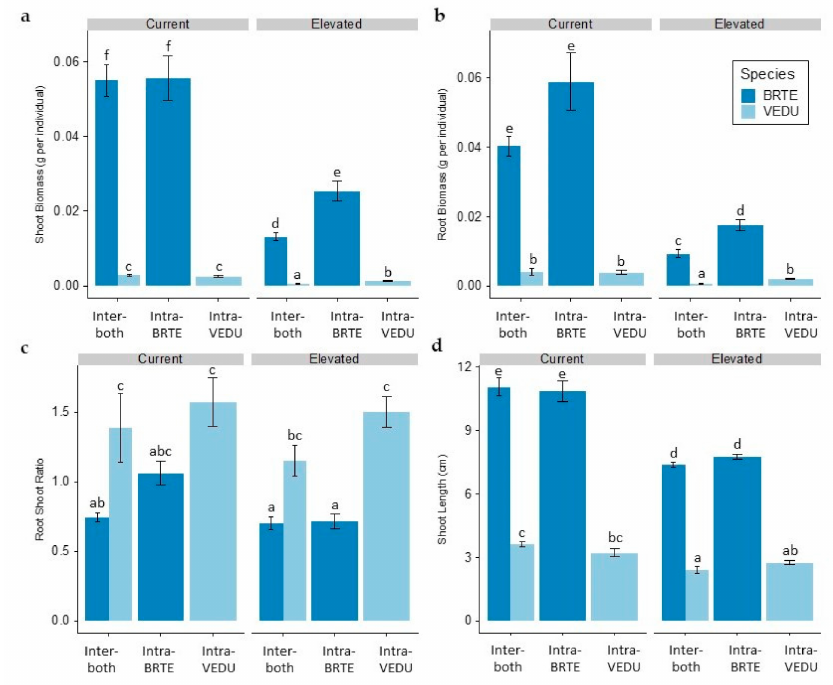
Figure 1. ( a ) Mean shoot biomass (g per individual), ( b ) mean root biomass (g per individual), ( c ) root–shoot ratio, and ( d ) mean shoot length (cm) for each species in competition and climate treatments. Competition treatments are indicated by Inter-both = Bromus tectorum + Ventenata dubia , Intra-BRTE = B. tectorum only, Intra-VEDU = V. dubia only. Climate treatments are Current (4 ◦ C / 23 ◦ C at 400 ppm CO 2 ) and Elevated (10.6 ◦ C / 29.6 ◦ C at 800 ppm CO 2 ) conditions. Error bars represent ± 1 standard deviation. Means with the same letter are similar to each other across all climate and competition treatments at α =